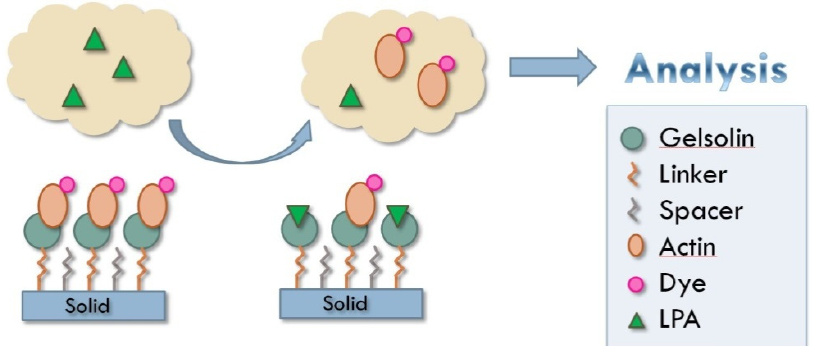
Figure 1. Principle behind actin–gelsolin chemistry for detection of LPA in patient samples. Solid support used in these experiments was silica gel.